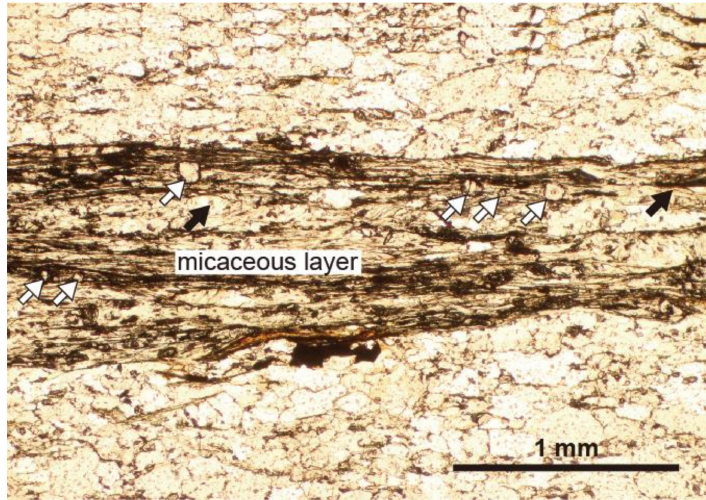
Figure 2. Photomicrograph of a polarizing microscope (plane-polarized light). Sample No. 20181125WYF. Micaceous lamella that defines the schistosity is seen in the center of the photo. Muscovite, chlorite, albite, and titanite are common in the micaceous lamellae. Carbonaceous material is often contained in albite and muscovite (black arrows). Upper and lower areas are mainly quartz. Euhedral garnet grains (white arrows) are exclusively found in the micaceous